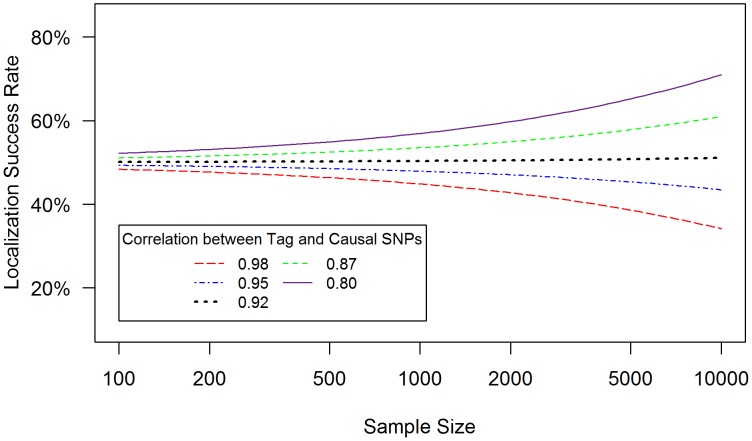
Well-tagged causal SNPs sequenced with low accuracy are unlikely to be correctly identified even as sample size increases.Localization success rates for association studies (sample size from 50∶50 cases∶controls to 5000∶5000 cases∶controls, X-axis) of one causal SNP (MAF = 0.12; OR = 1.25; imperfect genotyping accuracy due to sequencing or imputation errors resulting in correlation between the actual and estimated genotypes ρC = 0.95) and one tag SNP (MAF = 0.12; in high correlation with the causal SNP, rCG = 0.8 (purple solid) to 0.98 (red dashed); 100% genotyping accuracy with ρ
G
 = 1) with no selection for significance at the tag SNP.